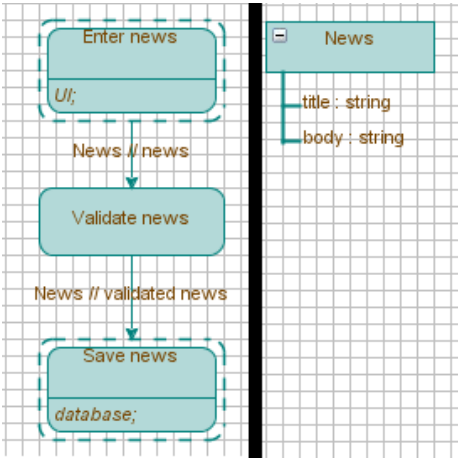
Fig. 8. Observer methods generated by ANTLR.